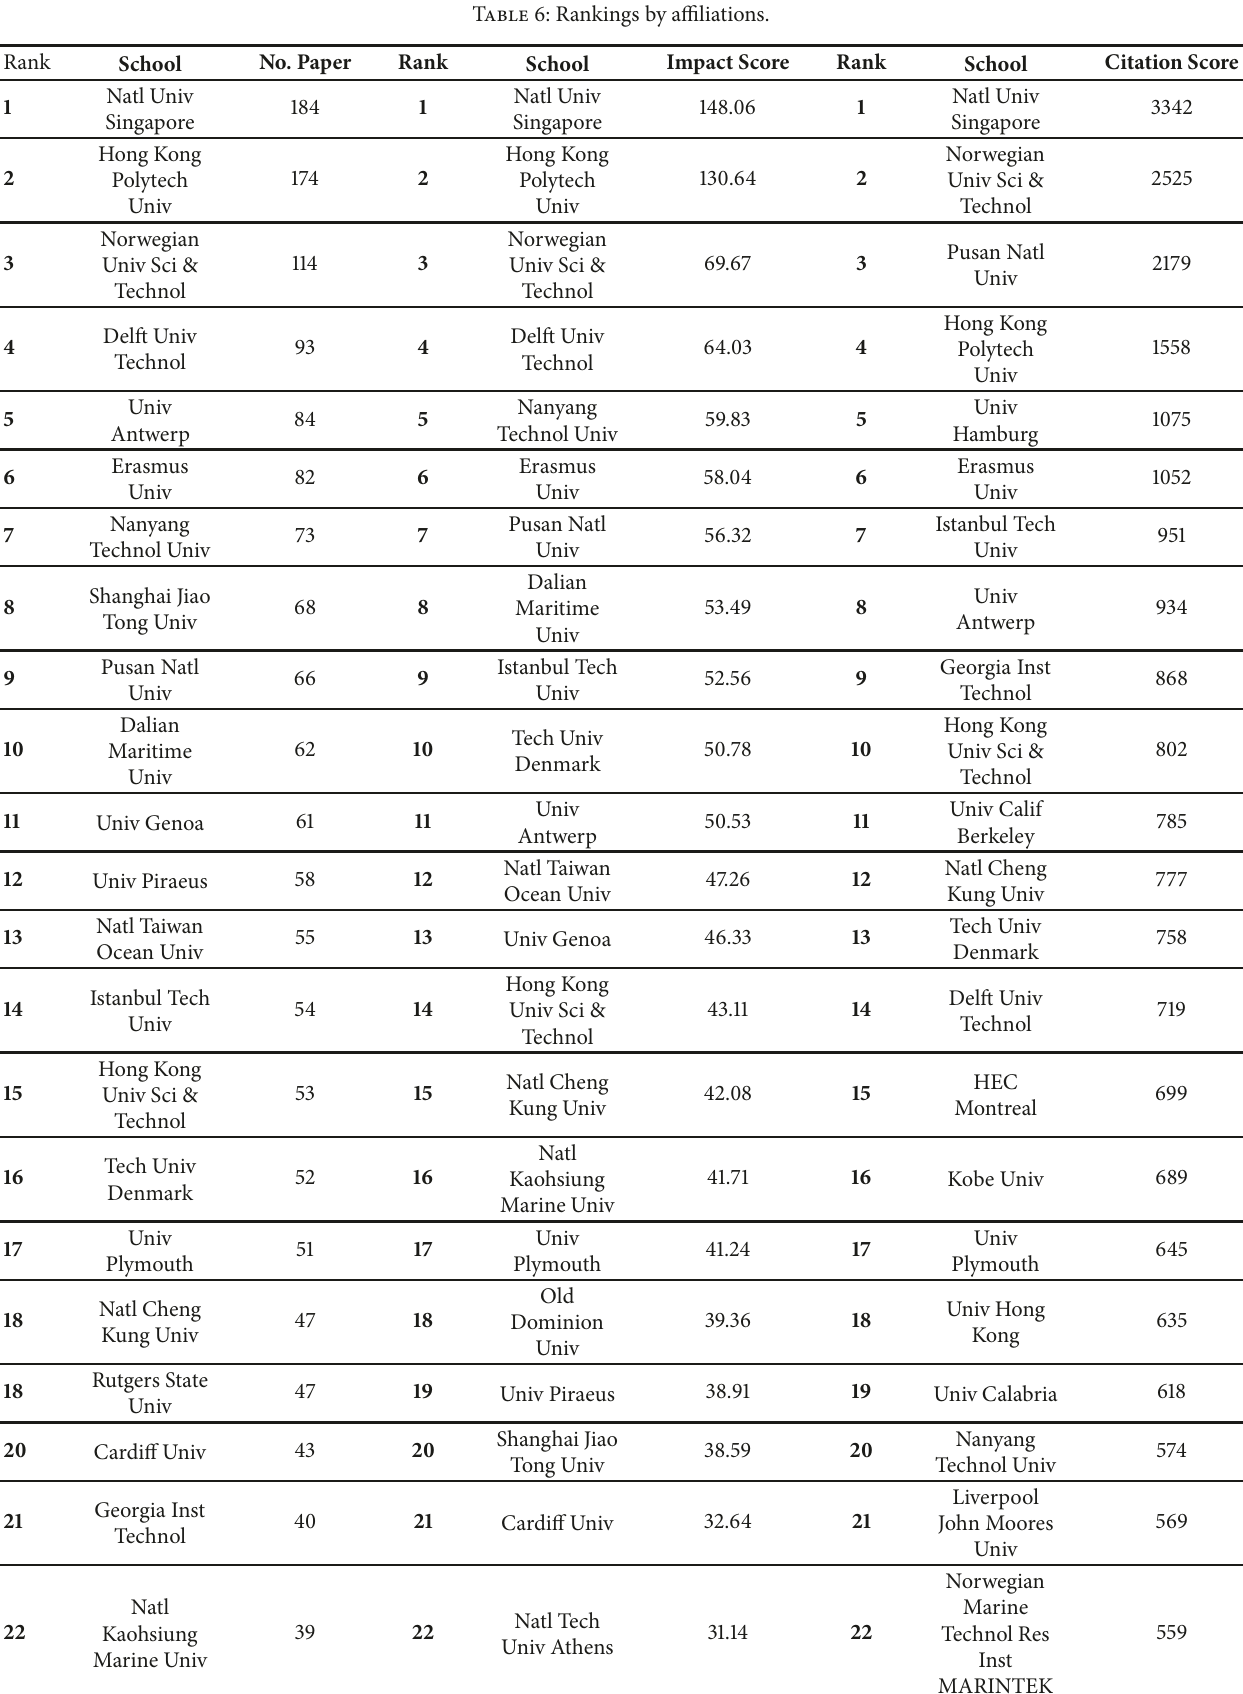
Table 6: Rankings by